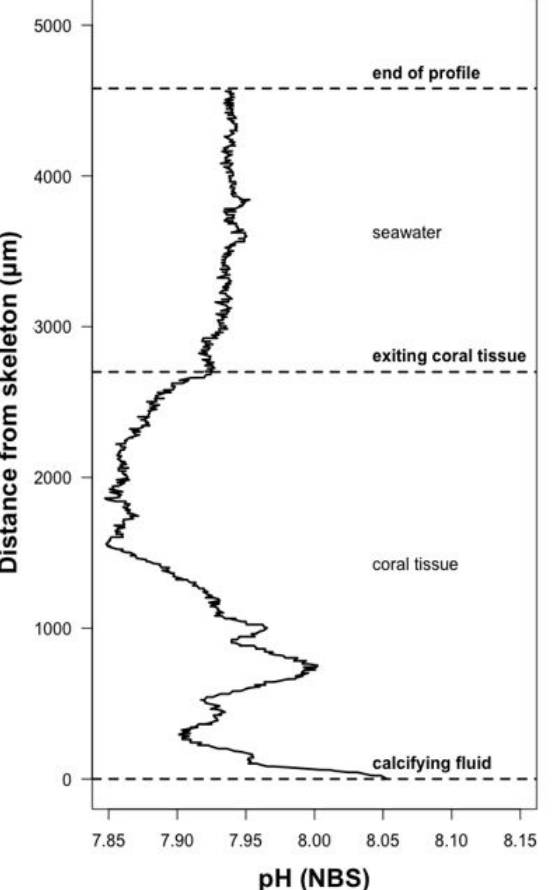
Figure 2. An example of a vertical pH profile generated during measurement of the coral calcifying fluid pH. This particular pH profile was generated for a specimen of S. hystrix cultured in the ‘1000 ppm pCO 2 , 28 °C’ treatment.